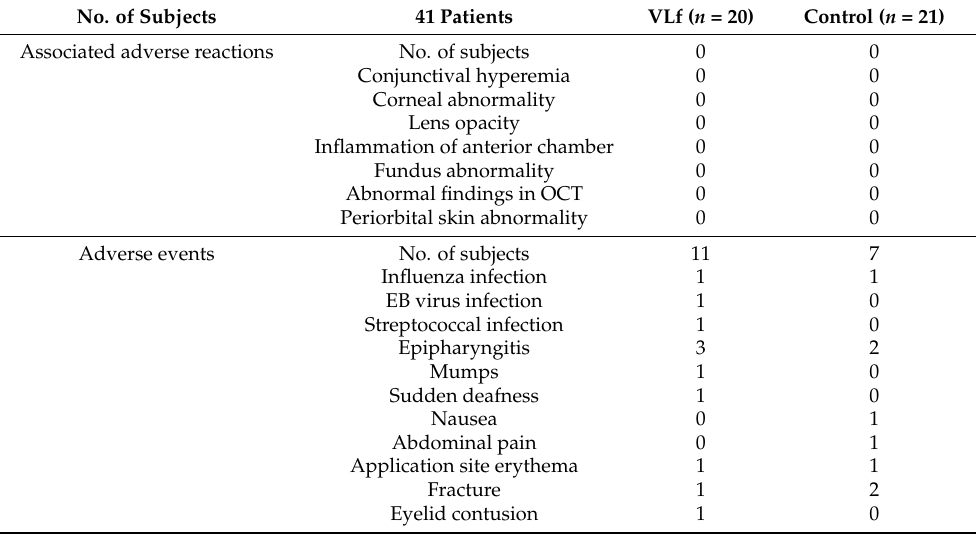
Table 2. Evaluation of safety with equipment of VLf or placebo